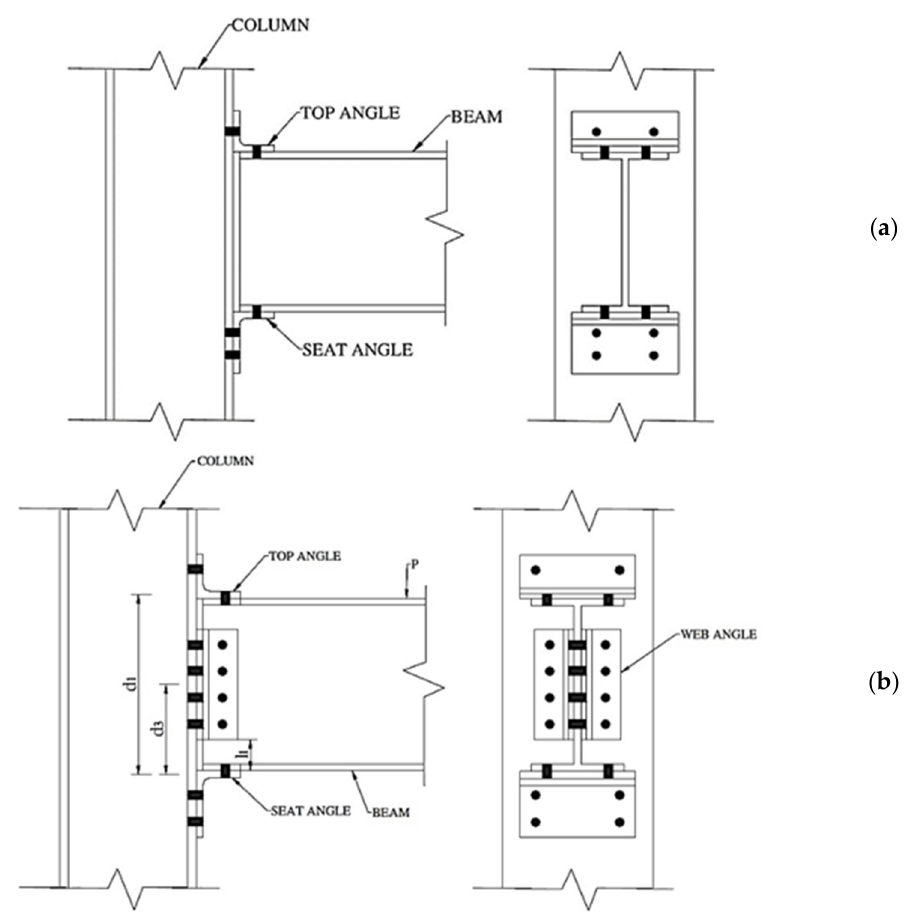
Figure 1. Reference configurations for ( a ) top-seat angle connections without (TSAC) or ( b ) with web angles (TSACW).